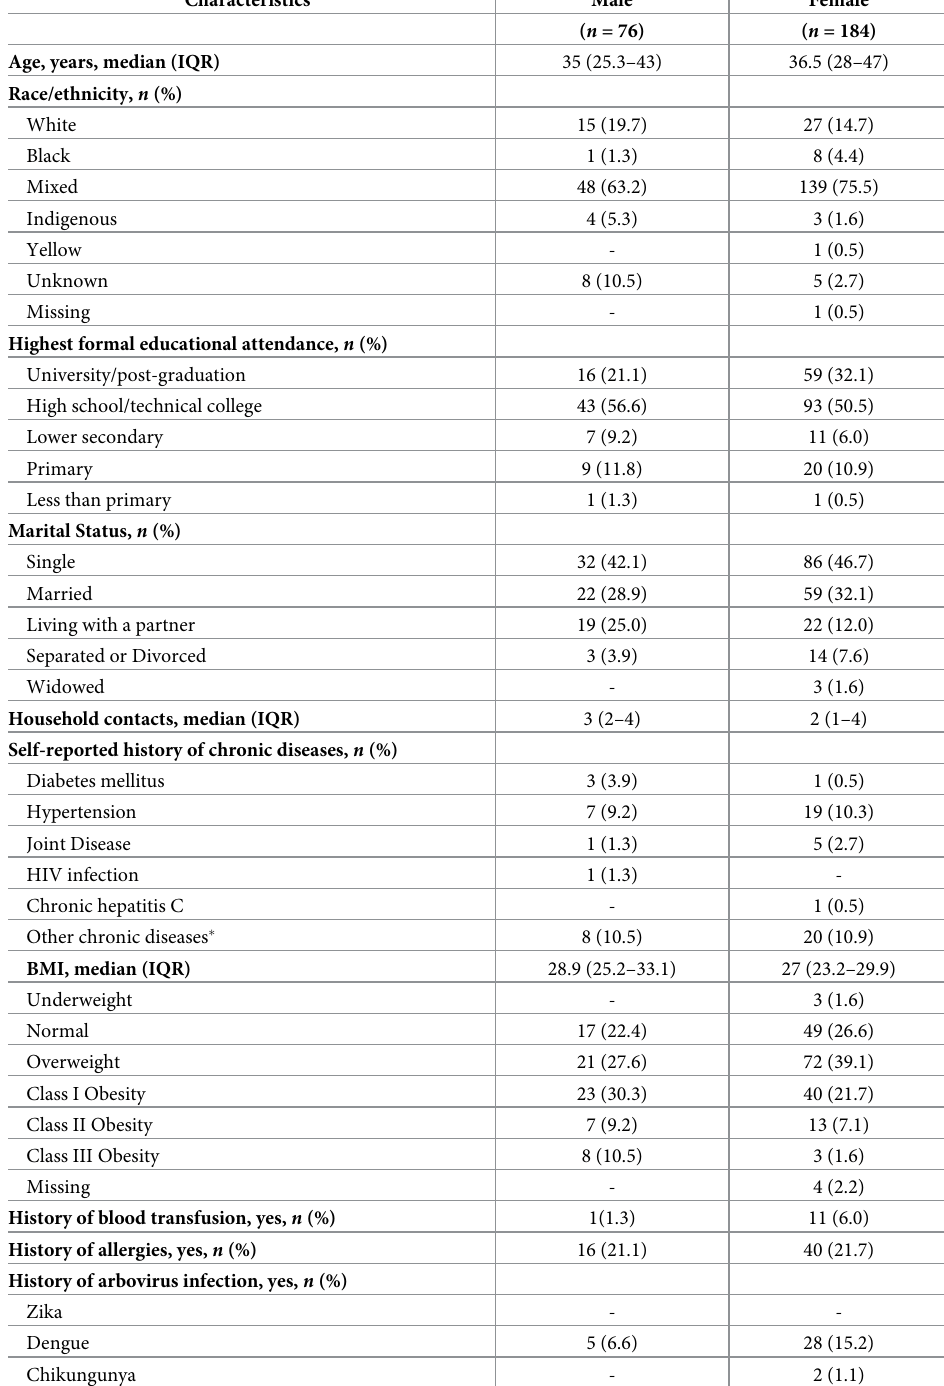
Table 3. Baseline characteristics of 260 study participants of the ZIKABRA study, by